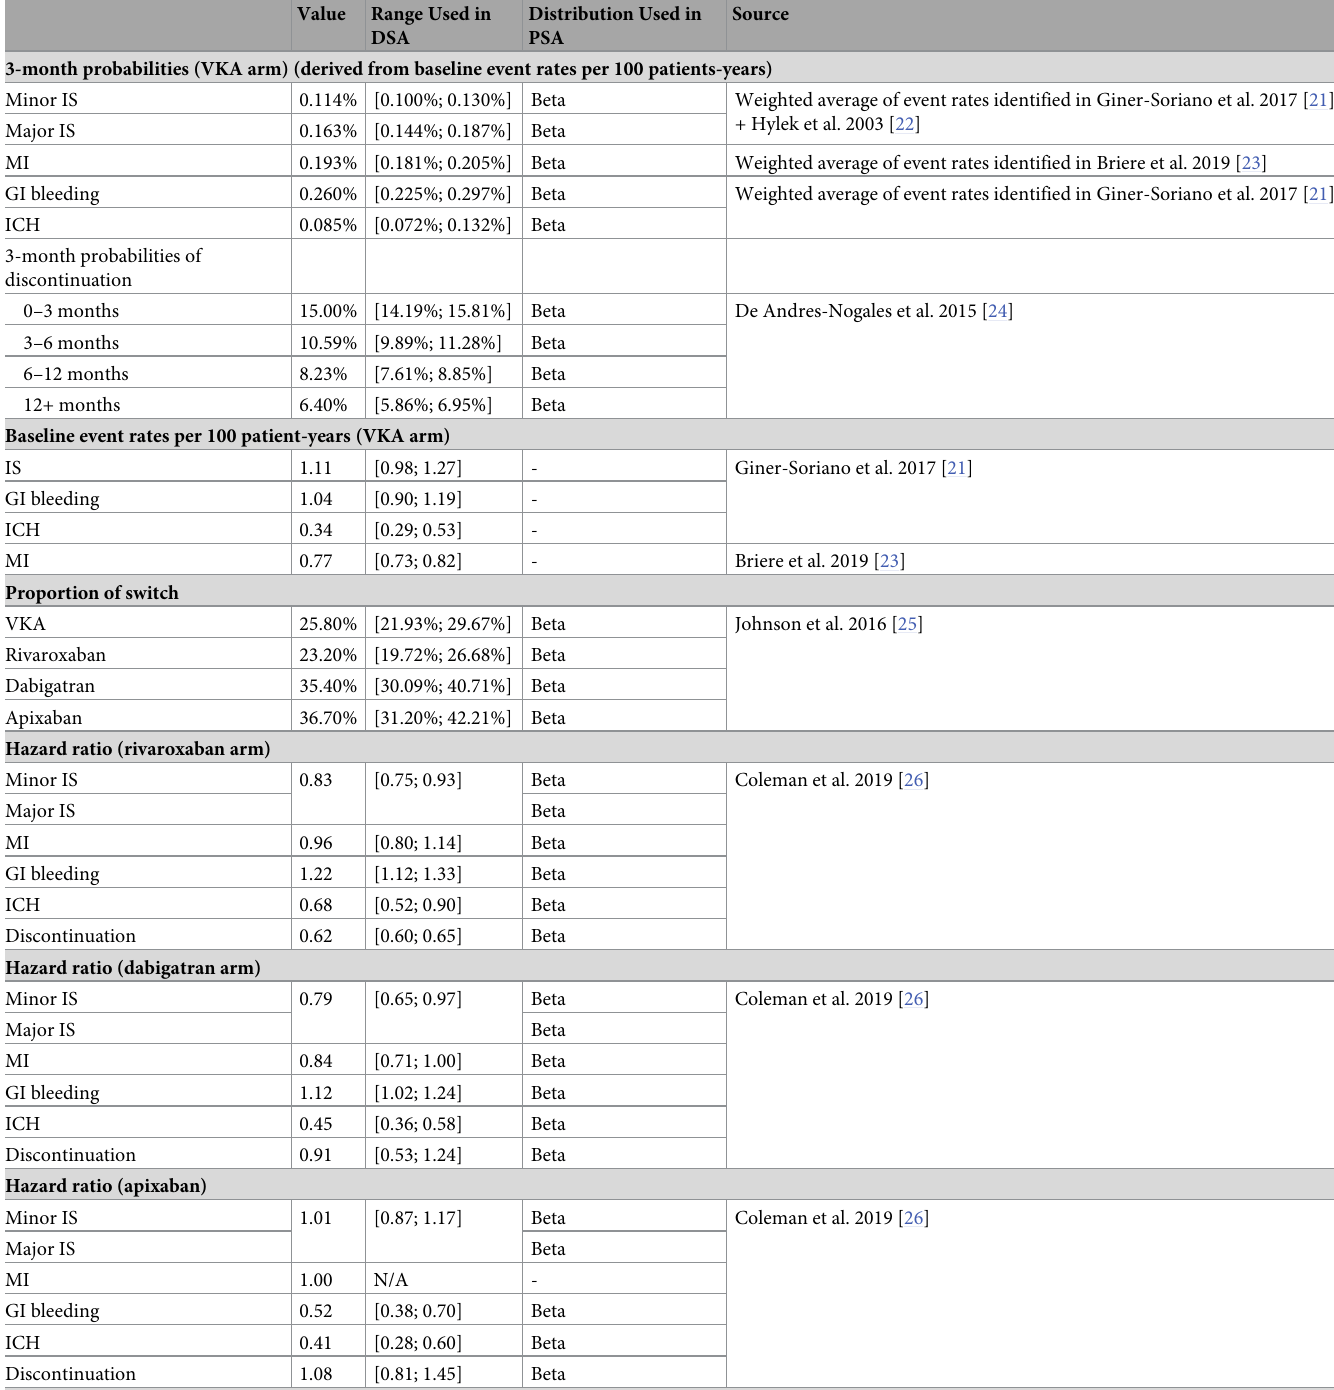
Table 1. Model inputs.